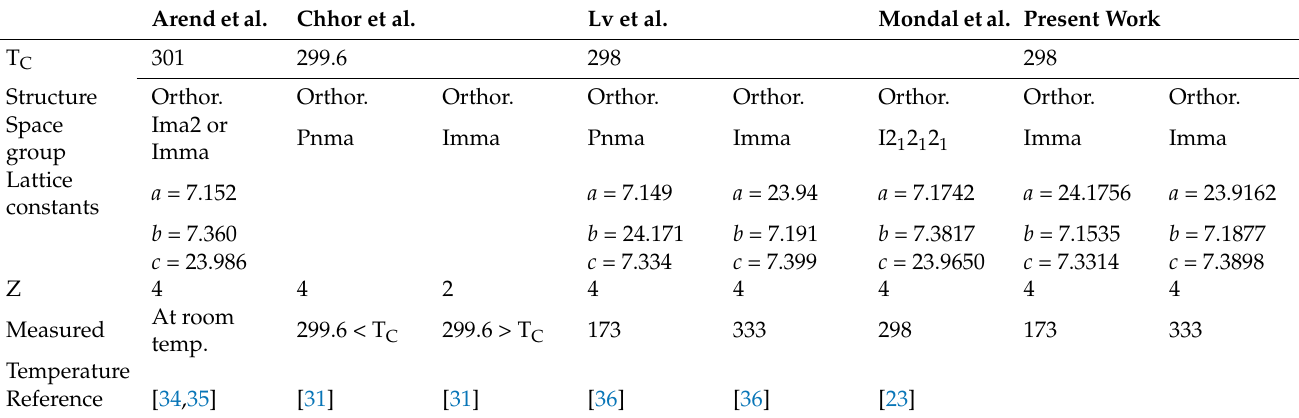
Table 2. Phase transition temperature T C (K), structure, space group, lattice constants (Å), Z,